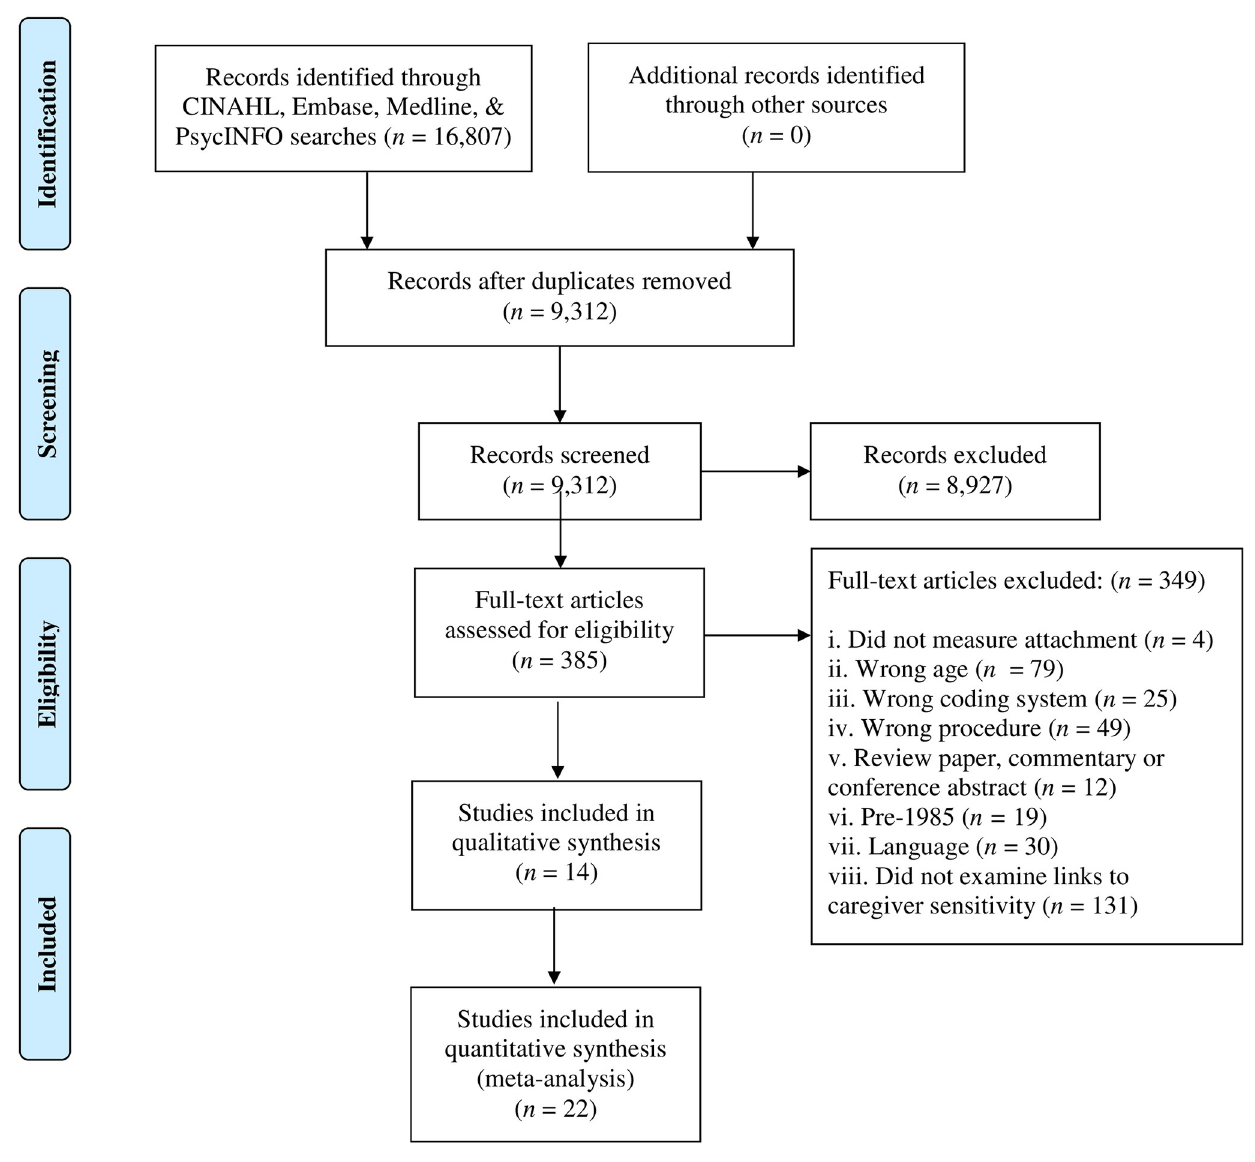
Fig 1. PRISMA flow